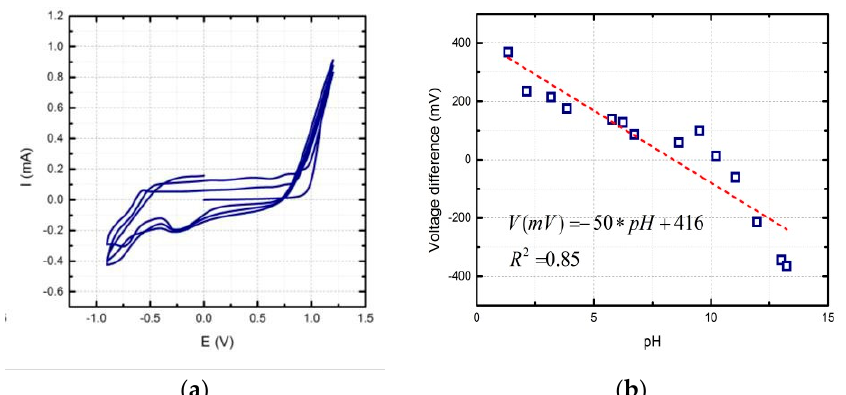
Figure 2. ( a ) Chemical structure of the cobaltabis(dicarbollide) [3,3 ′ -Co(1,2-C2B9H11)2] − anion; ( b ) Nernstian evolution of the voltage measured by the ion-sensitive electrode with the pH of solution, with linear behavior along the whole pH